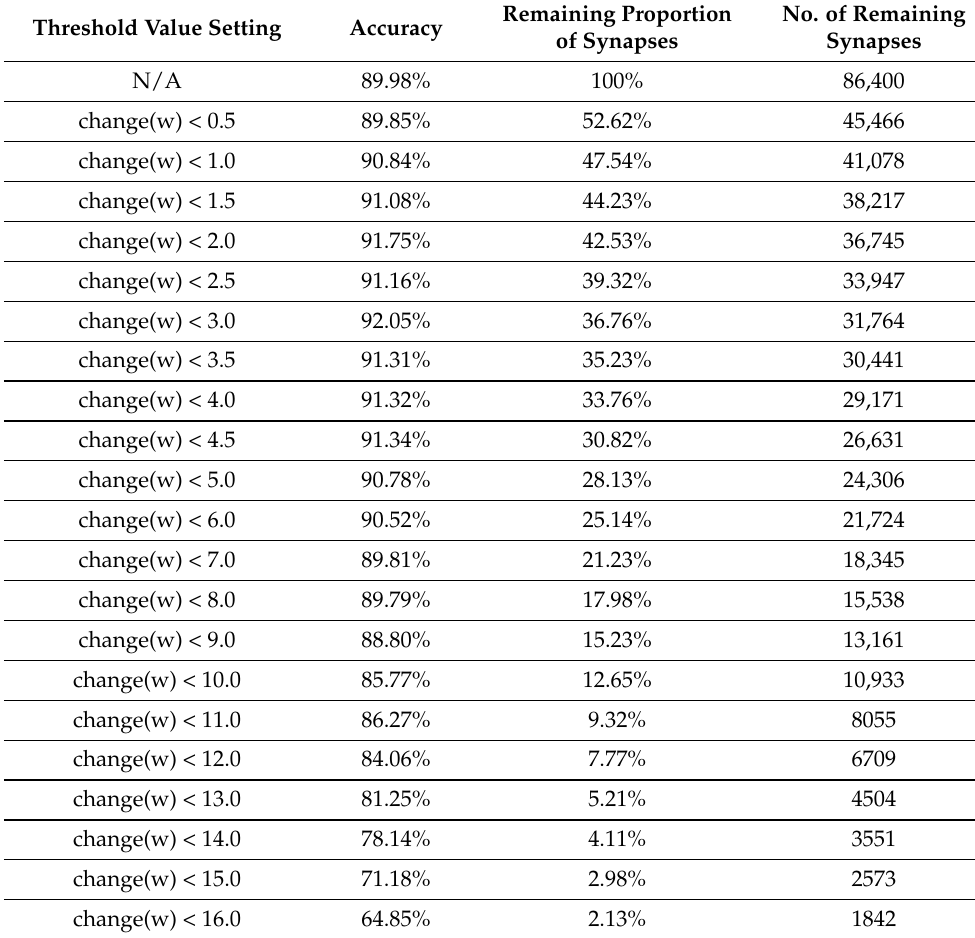
Table 1. Effect of structural learning. N/A represents the case where only synaptic learning is carried out.